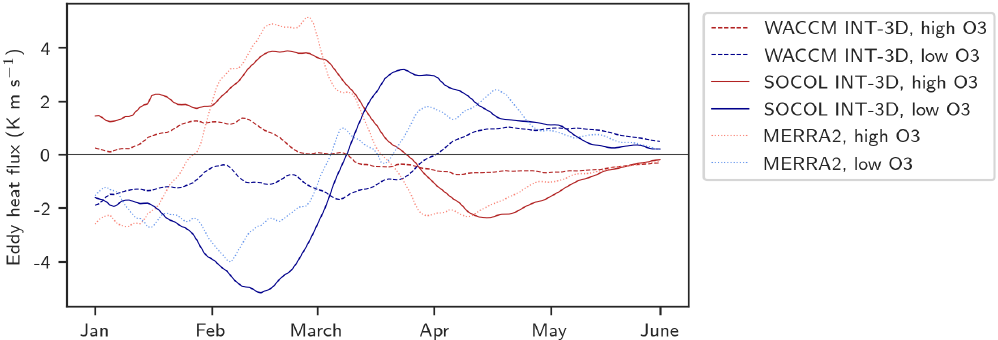
Figure A5. Heat flux at 100hPa in high- and low-ozone springs. Eddy heat flux anomalies (Kms − 1 , 30d running mean) averaged over